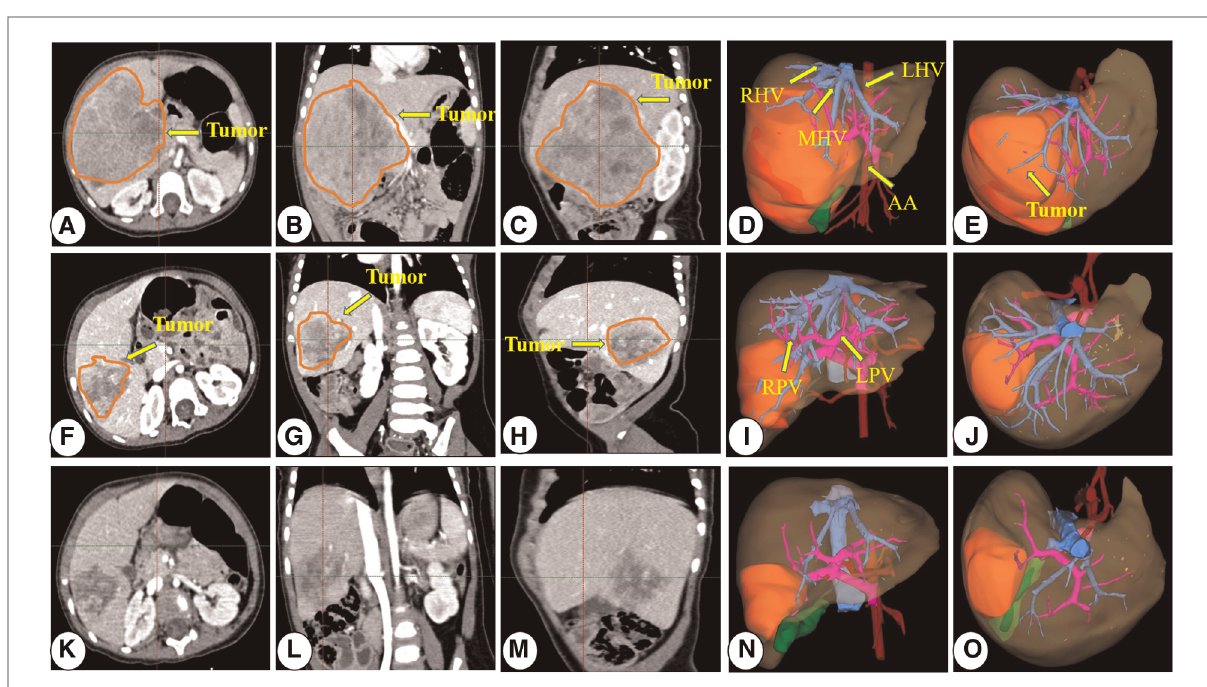
FIGURE 2 Representative preoperative chemotherapy assessment of a patient who underwent neoadjuvant chemotherapy before surgical resection. ( A – E ) CT images and 3D reconstruction images at diagnosis; ( E – J ) CT images and 3D reconstruction images after two courses of preoperative chemotherapy; ( K – O ) CT images and 3D reconstruction images after three courses of preoperative chemotherapy. CT, computed tomography; 3D, three- dimensional; RPV, right portal vein; LPV, left portal vein; PV, portal vein; RHV, right hepatic vein; LHV, left hepatic vein; MHV, middle hepatic vein; AA, abdominal